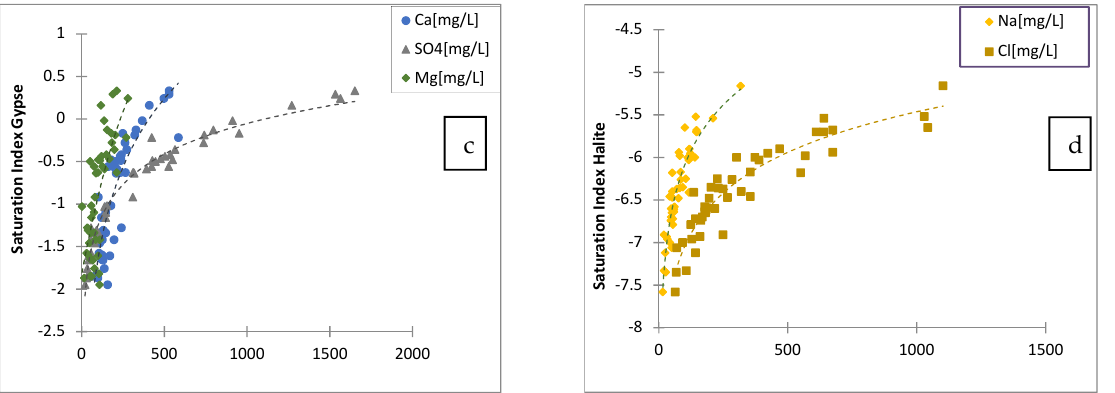
Figure 12. Correlation between the saturation indexes and dissolved major ions ( a ) Mg, ( b ) Ca, ( c ) Mg, ( d ) Cl.